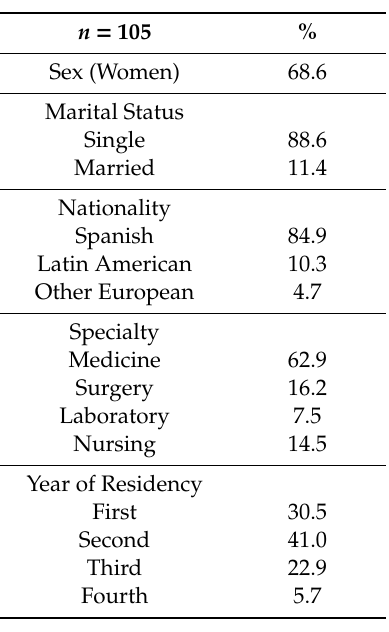
Table 1. Demographic characteristics of the